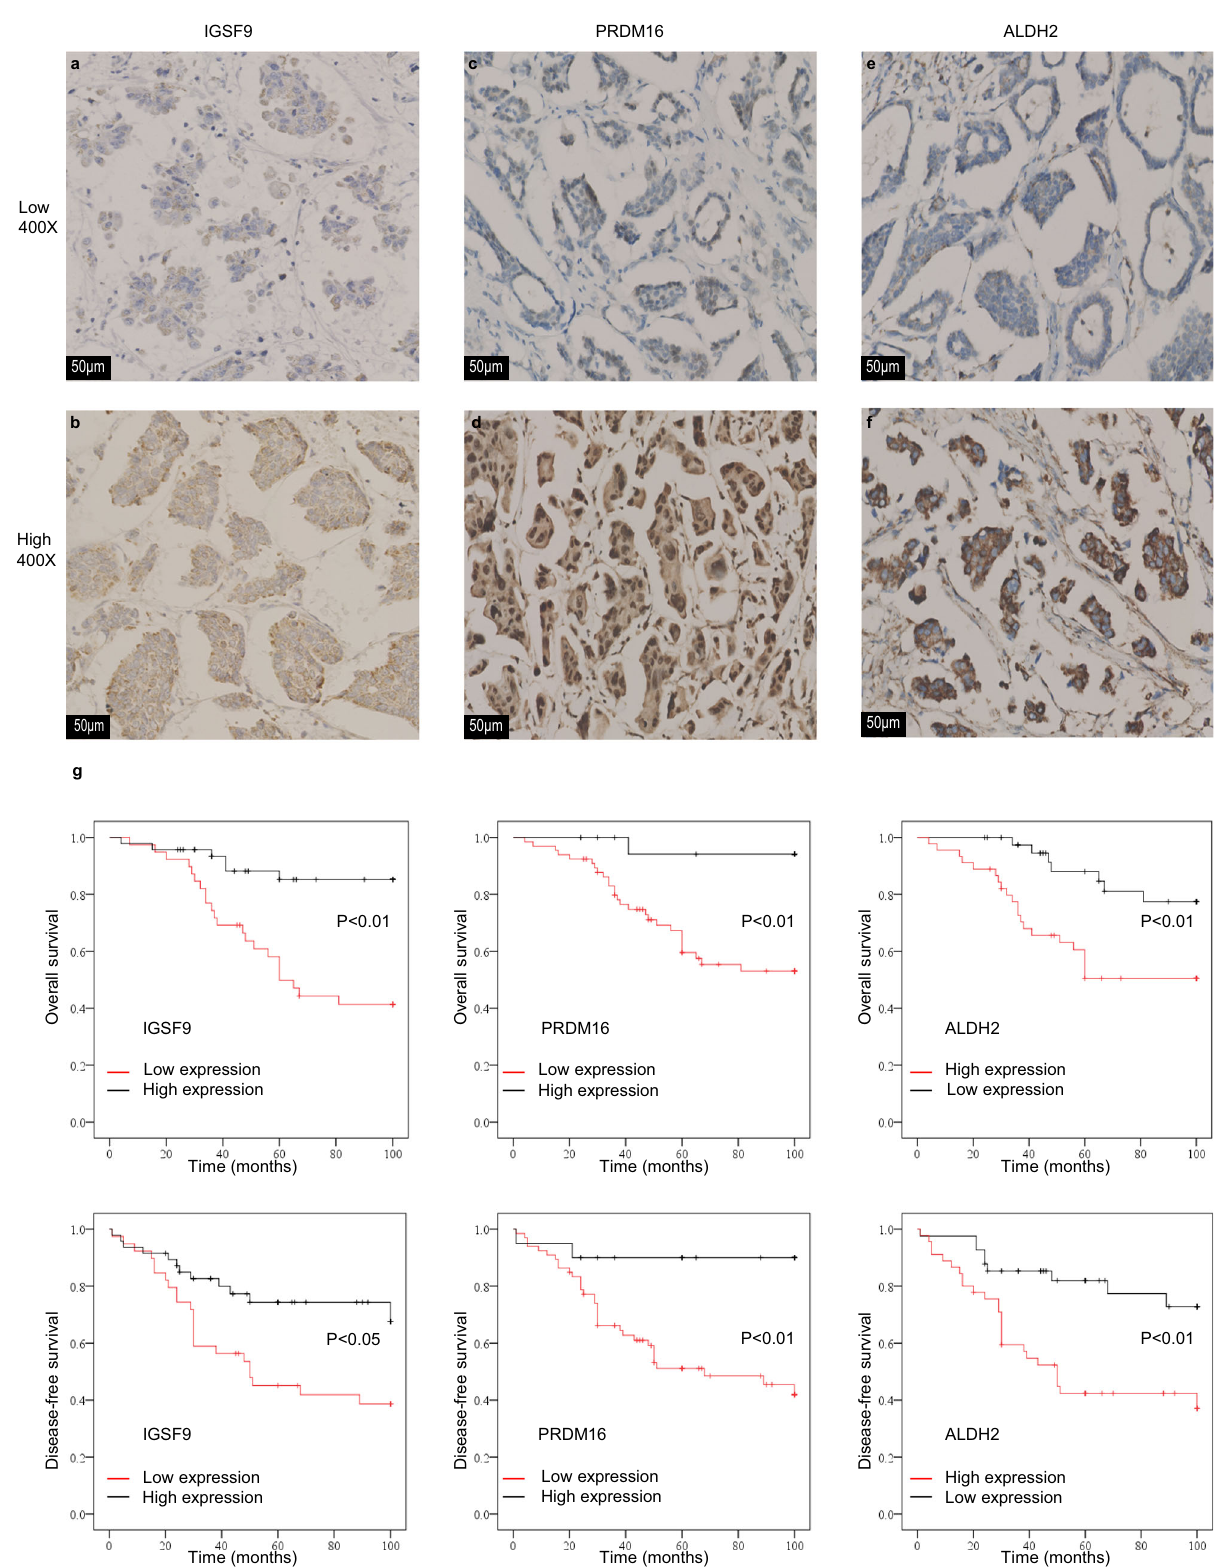
(versus lower) expression of the ALDH2 protein was associated with shorter OS and DFS (based on the log-rank test, P < 0.01 for both) (Fig. 7g). Further clinicopathological analyses of these three genes are shown in Supplementary Data 8 and 9. Consistent with